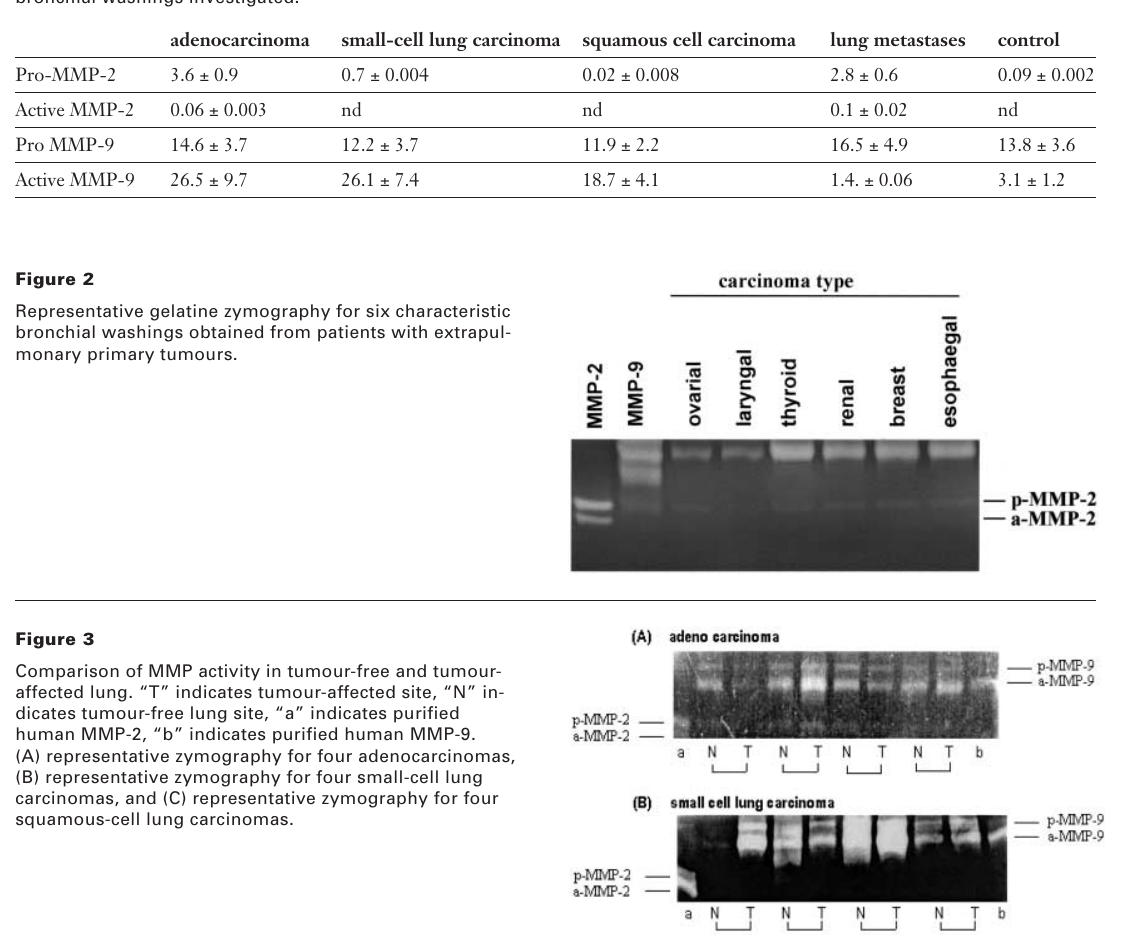
Densitometric analysis of gelatine zymograms grouped by lung tumour types. The optical density of MMP bands was quanti- fied defining the optical density generated by zymography of 1 ng/ml purified human MMP-2 or MMP-9 as one standard unit. The data represent the mean ± S.E. of the respective number of zymograms. Active MMP-2 was not detectable in any of the bronchial washings investigated.